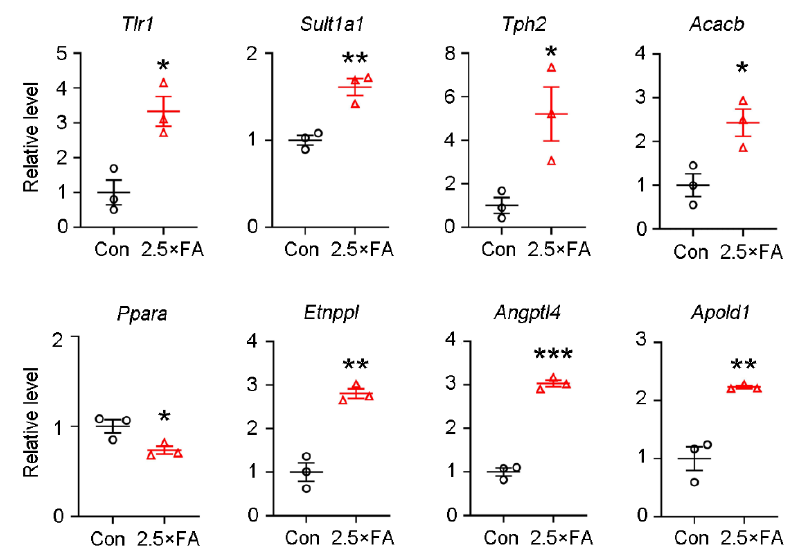
Figure 6. DEGs enriched in the GO category of cellular component were validated by qRT-PCR. The relative mRNA expression level of Tlr1 , Sult1a1 , Tph2 , Acacb , Ppara , Etnppl , Angptl4 and Apold1 genes in control and 2.5 × FA brains ( n = 3) were determined by qRT-PCR. The levels of ribosomal protein S18 (RPS18) mRNA were used for normalization. *, p < 0.05; **, p < 0.01; ***, p < 0.001. The protein expression of 2.5 × FA brains was then analyzed using Western blots.